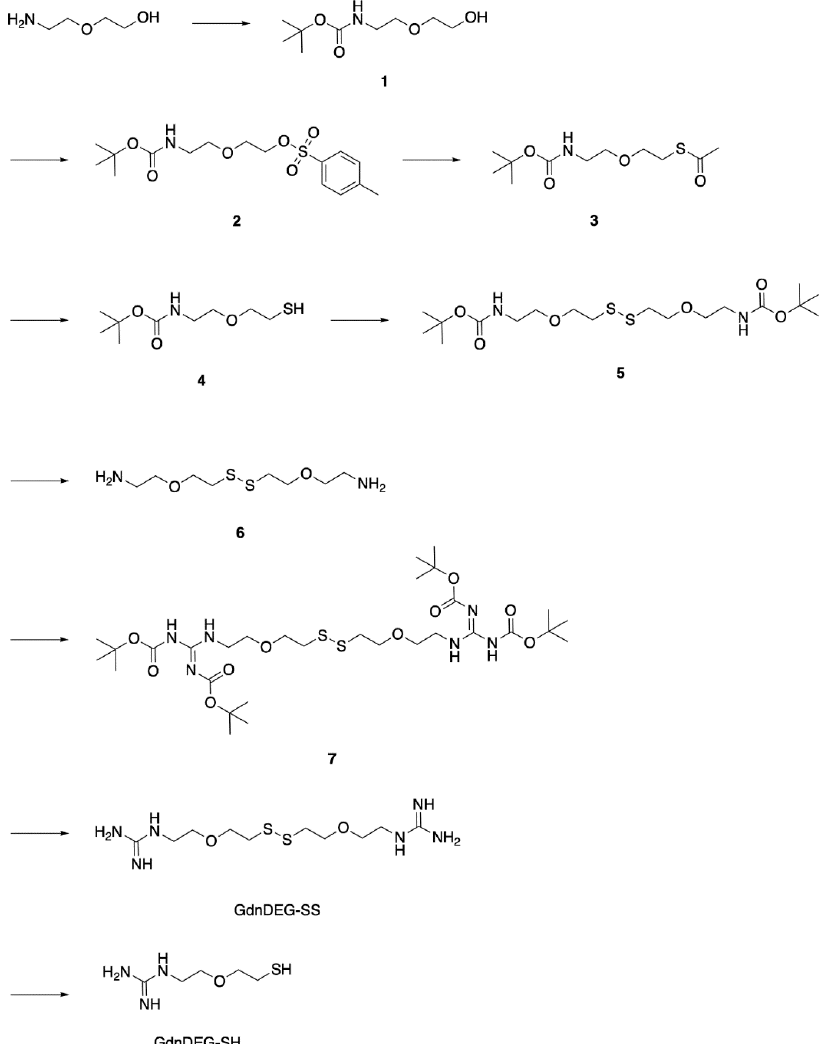
Figure 2. Synthetic scheme of GdnDEG-SH.